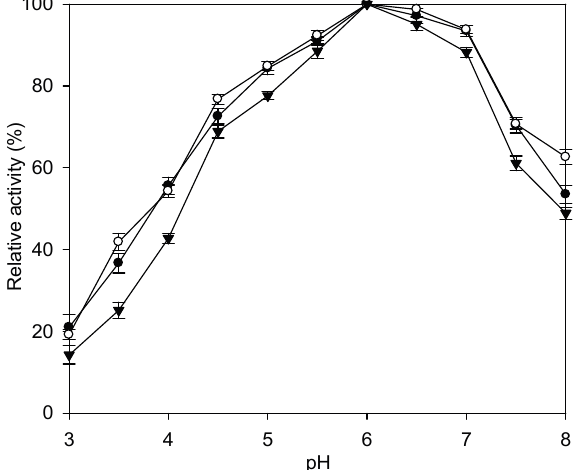
Figure 4. Effect of pH on the relative enzyme activity at 50 °C. Fe 3 O 4 -CS-immobilized enzyme (0.2 g), Fe 3 O 4 -CS-THP-immobilized enzyme (0.2 g) or the free enzyme (1 mL) was added to 100 mL of 5% (w·v − 1 ) lactose at 50 °C in a 500 mL Erlenmeyer flask and incubated at various pH from 3.0 to 8.0 in an orbital shaker bath at 200 rpm for 10 min. The relative activity was determined by measuring the production of glucose. The buffer used in this set of reactions were 0.1 M sodium acetate buffer (pH 3.0~5.6) and 0.1 M potassium dihydrogen orthophosphate (pH 5.8~8.0). The data are averaged from three samples. ( ● ) Fe 3 O 4 -CS-immobilized enzyme; ( ○ ) Fe 3 O 4 -CS-THP-immobilized enzyme; ( ▼ ) free